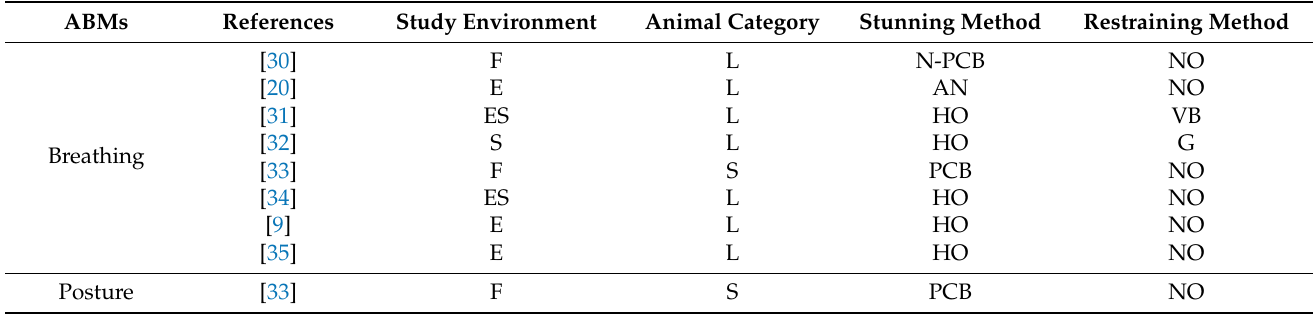
Table 3. Critical evaluation of the feasibility of ABMs derived from the literature review—Study Environment. For each study, we report the study